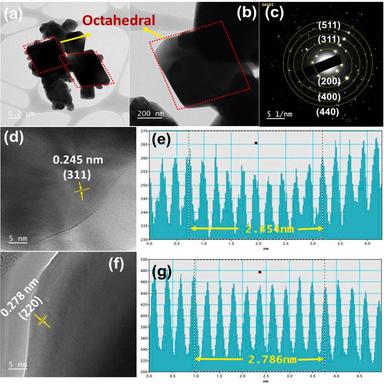
TEM (a,b), SAED (c), HRTEM (d,f), and equivalent line spacing profiles (e,g) of 6%Cu–Co3O4.